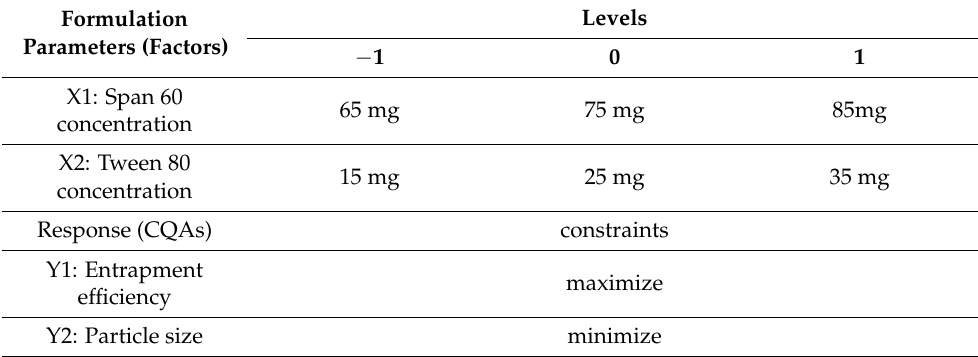
Table 1. Experimental range of formulation parameters (factors) and critical quality attributes (CQAs) of zolmitriptan-loaded spanlastics.